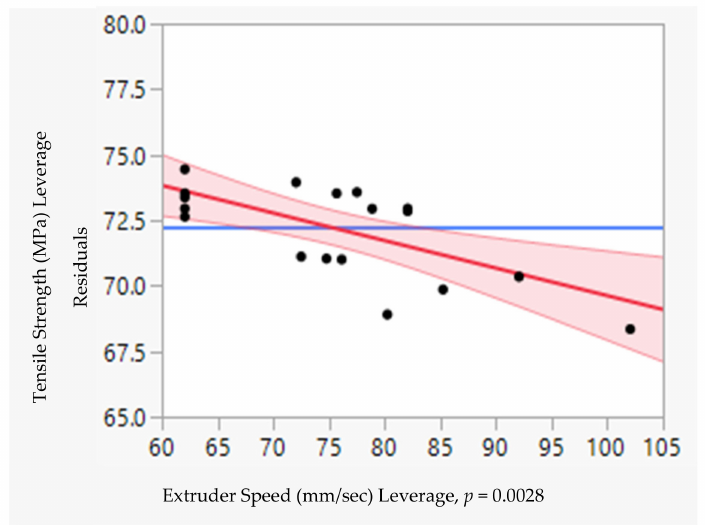
Figure 15. Tensile strength vs. extruder speed. 3.5. Leverage Plot of Shell Thickness vs. Tensile Strength The plot in Figure 16 shows p = 0.001, which is less than 0.005, indicating that shell thickness was a highly significant process parameter.